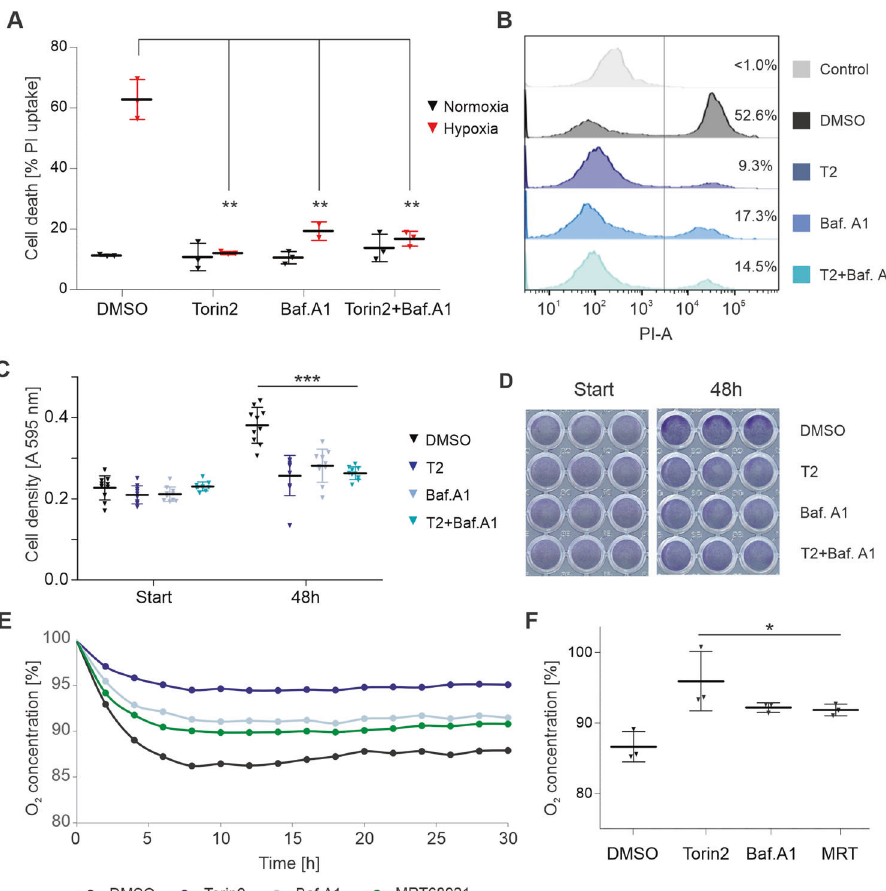
Fig. 2 Inhibition of autophagy protects glioma cells from hypoxia-induced cell death. A LN-229 cells were subjected to nutrient starvation in either normoxia or 0.1% hypoxia, and were treated with torin 2 (100 nM) or ba fi lomycin A1 (100 nM) as indicated. Cell death was quanti fi ed by propidium iodide staining. Data represent mean ± SD ( n = 3, ** p < 0.01, Student ’ s t -test). B Representative histograms of A of cells exposed to hypoxia. PI-unstained cells served as negative control. Numbers indicate the percentage of PI-positive cells. C , D Crystal violet staining was used to quantify cell density. Data represent mean ± SD ( n = 10, *** p < 0.001, Student ’ s t -test). E Quanti fi ca t ion of oxygen consumption by a fl uorescence-based assay. LN-229 cells were exposed to serum-free medium containing 2 mM glucose and were treated with torin 2 (100 nM), ba fi lomycin A1 (100 nM) or MRT68921 (1 µM) as indicated. Oxygen consumption is shown relative to the start of the experiment as mean ( n = 3). F End point analysis of E ( n = 3, * p < 0.05, Student ’ s t -test). Abbreviations: T2 = torin2; Baf. A1 = ba fi lomycin